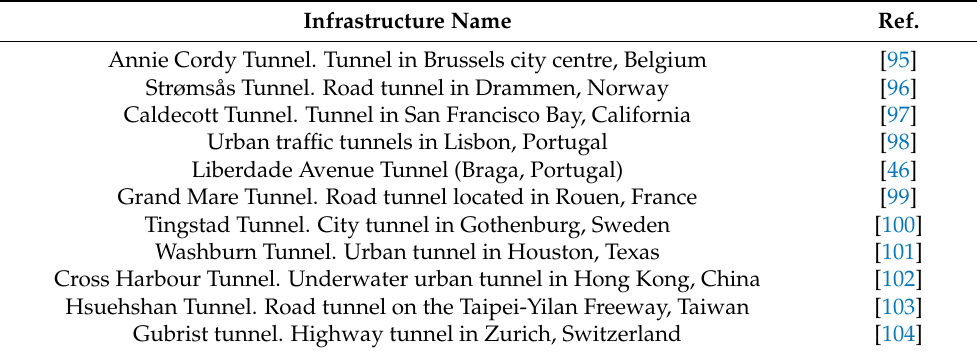
Table 2. Compilation of tunnels in which research projects aimed at measuring gas